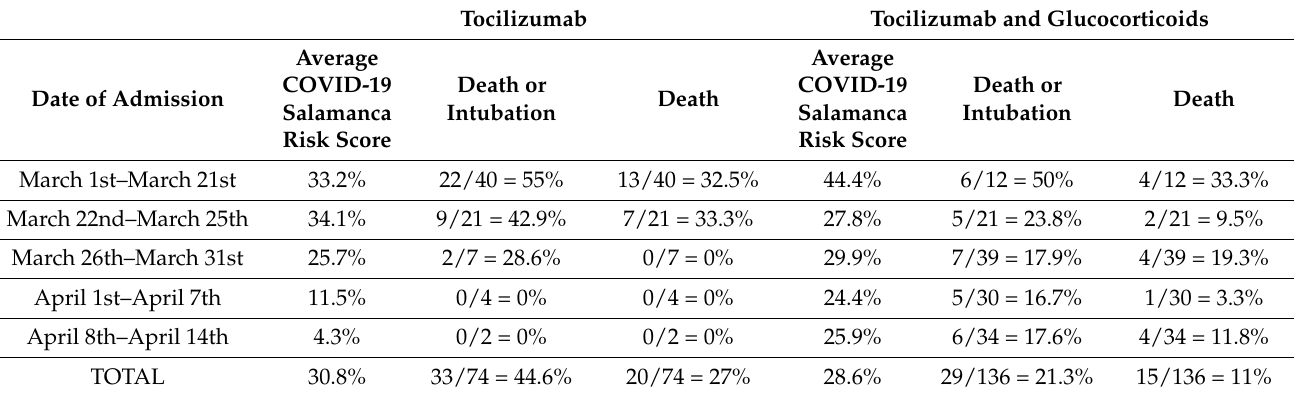
Table 4. Mortality and severity for each treatment group by date of admission.